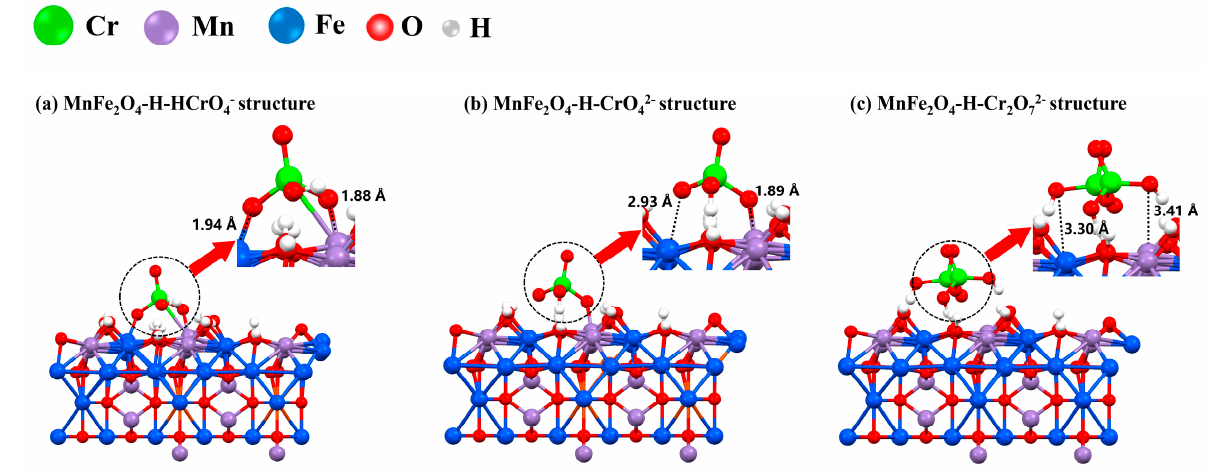
Figure 6. The optimum structure of MnFe 2 O 4 − H − HcrO 4 − ( a ), MnFe 2 O 4 − H − CrO 42 − , ( b ) and MnFe 2 O 4 − H − Cr 2 O 72 − ( c ). Table 3. Comparison of the results of this research with other related research. Adsorbents